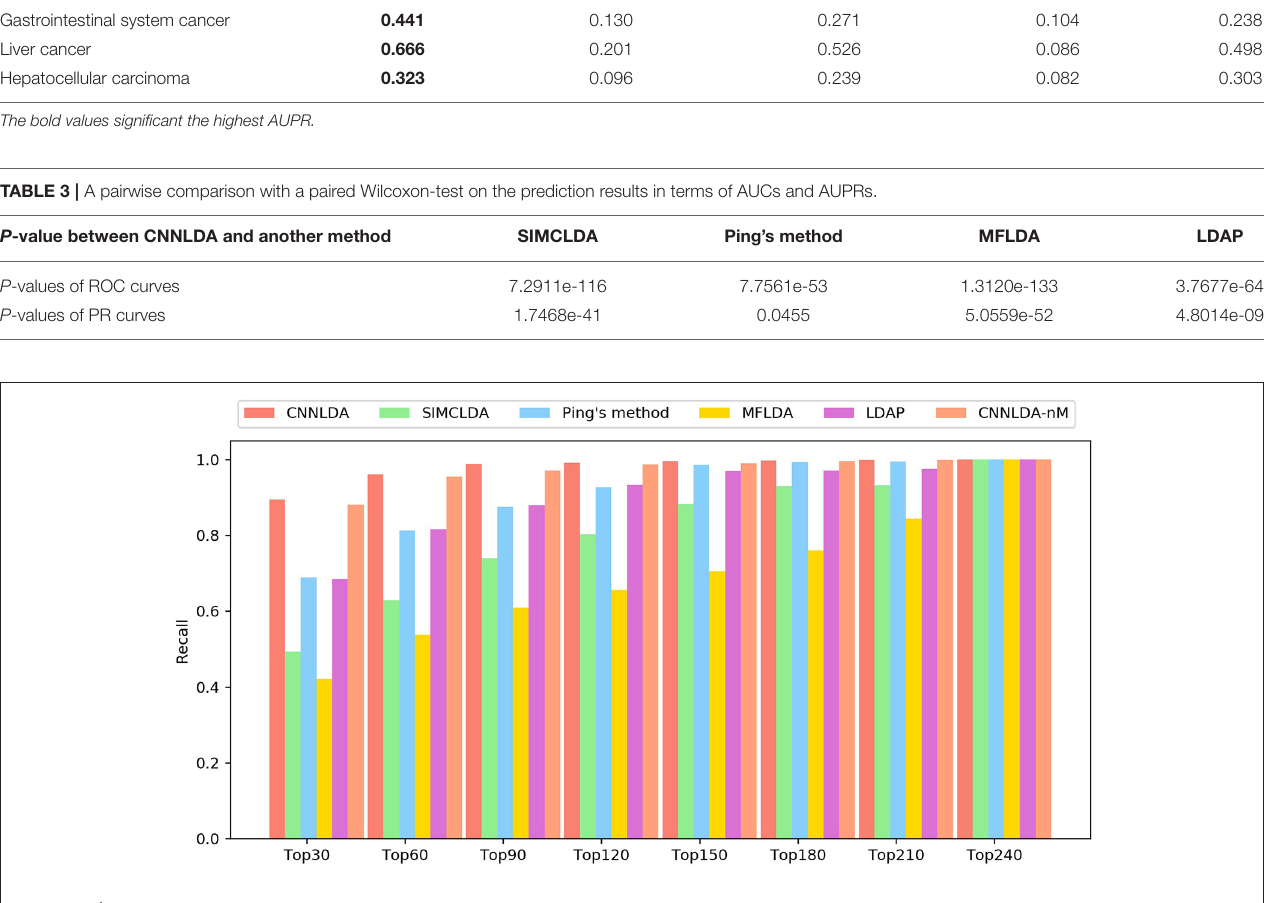
FIGURE 4 | The average recalls across all the tested diseases under different top k